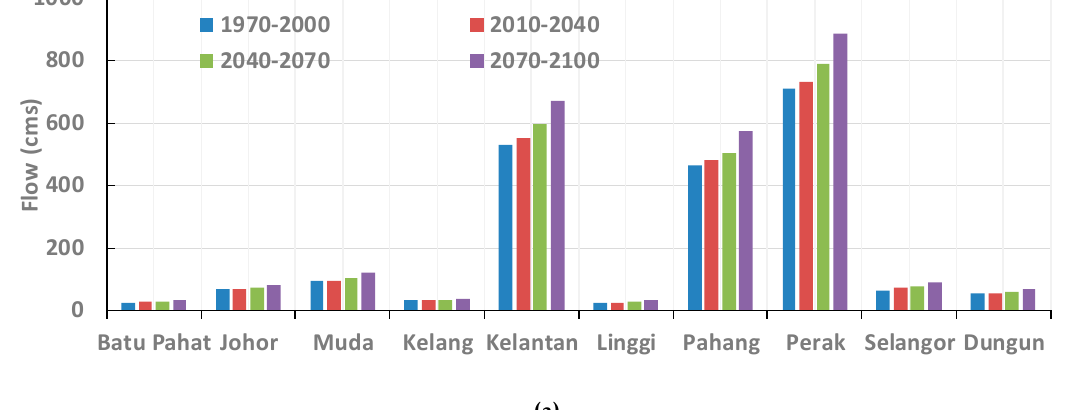
Figure 9. Normalized values of 30-year mean of the basin-average annual mean soil water storage during the historical period (1970 − 2000) and through the 21st century for the a) 10 watersheds, and b) 12 coastal regions in Peninsular Malaysia. 30-year mean of the basin-average annual mean soil water storage values are normalized by the values of the 1970 − 2000 period. ( a ) 10 watersheds; ( b ) 12 Coastal Regions (CRs).